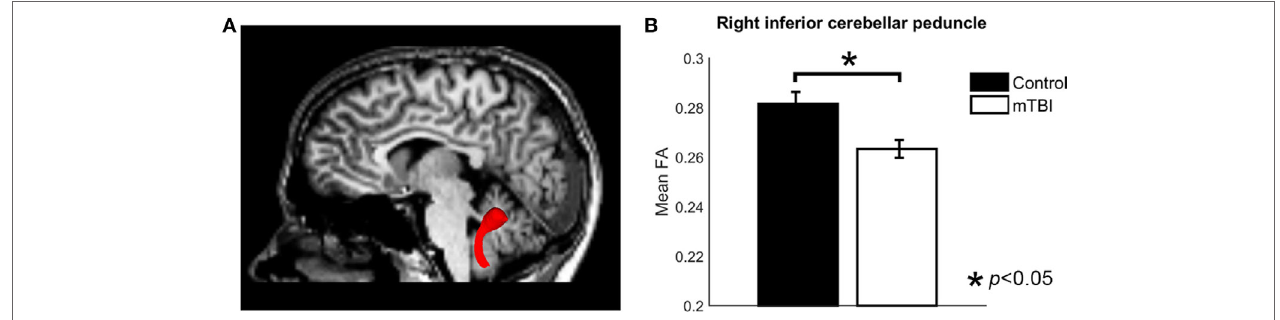
FigUre 2 | The analysis of fractional anisotropy (FA) for control and mild traumatic brain injury (mTBI) groups. (a) Image showing the inferior cerebellar peduncle region of interest. (B) A bar plot comparing the mean FA value of right ICP between control and mTBI groups.